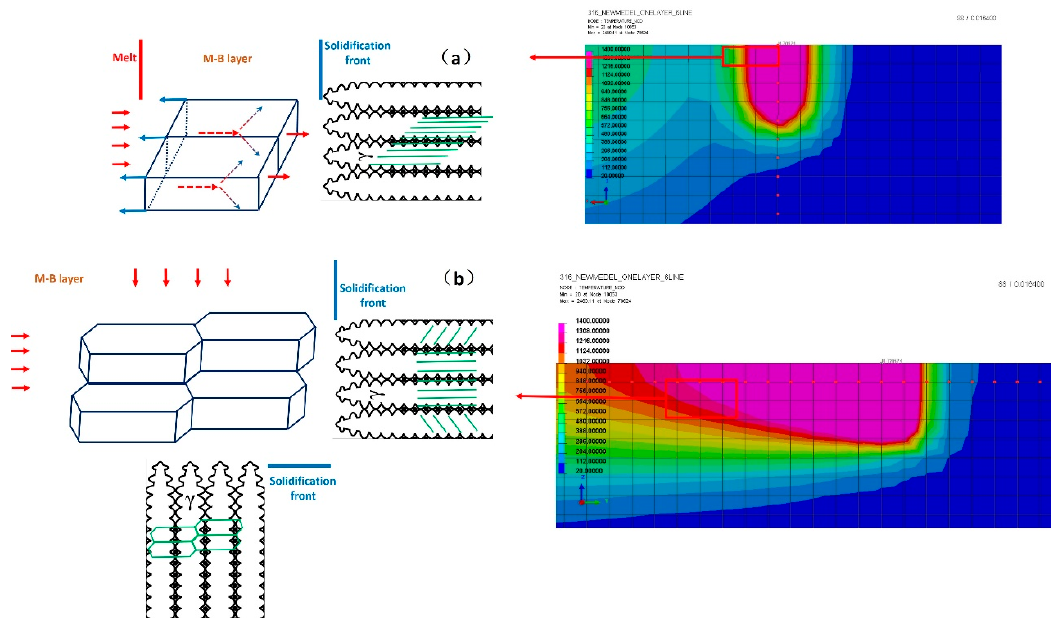
Figure 9. The forming mechanism of the bands in ( a ) and mixed patterns with cellular, elongated cellular and bands structures in ( b ).